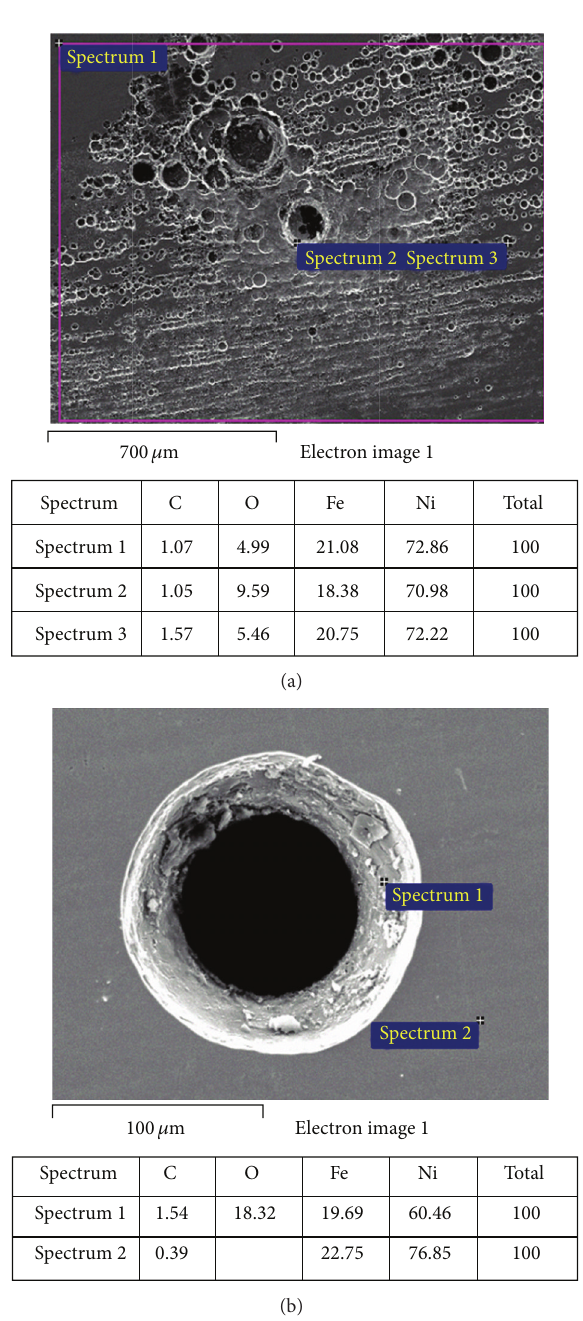
Figure 4: (a) SEM/EDS of the 20% Fe-Ni sheet after corrosion tests in 0.1M 1M NaCl solution and (b) SEM/EDS of pit morphology and composition in 20% Fe-Ni sheet after corrosion tests in 0.1M